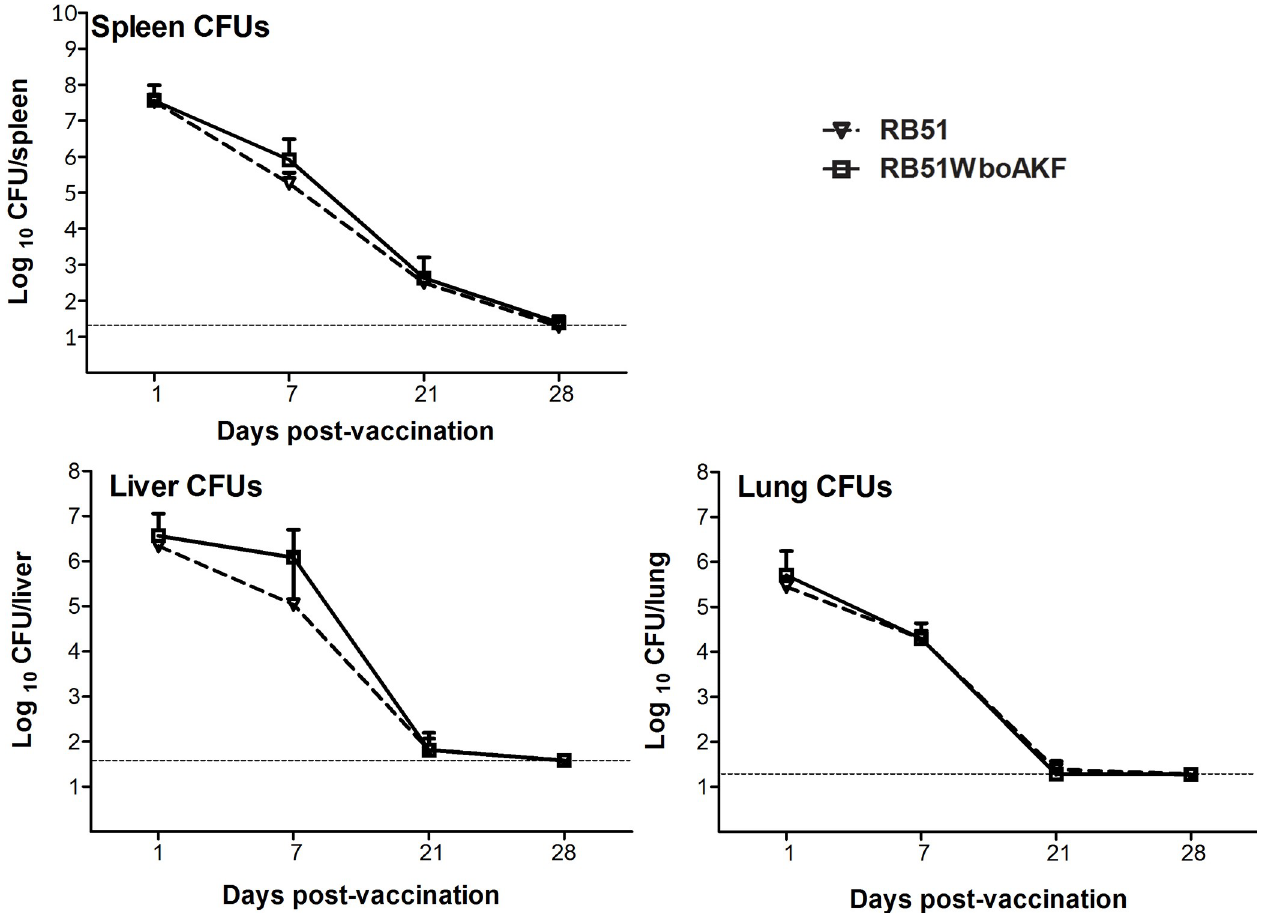
Fig 6. Persistence of strain RB51WboAKF in mice. Mice spleens, livers and lungs were collected at days 1, 7, 21 and 28 after vaccination with live RB51 and live RB51WboAKF. The Brucella CFUs in these organs were determined as described in Materials and Methods. Results are shown as mean ± standard deviation (n = 3) of the log CFU of Brucella recovered from each organ. Horizontal broken line above the x-axis indicates the lower limit of detection ( < 20 CFU/spleen and lungs, < 40 CFU/liver).